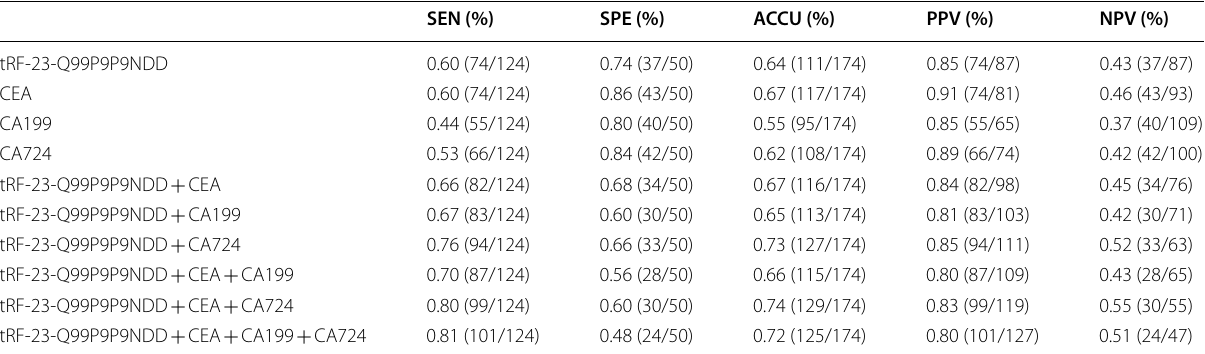
Table 5 The diagnostic performance of tRF-23-Q99P9P9NDD, CEA, CA199 and CA724 in differentiating GC patients from gastritis